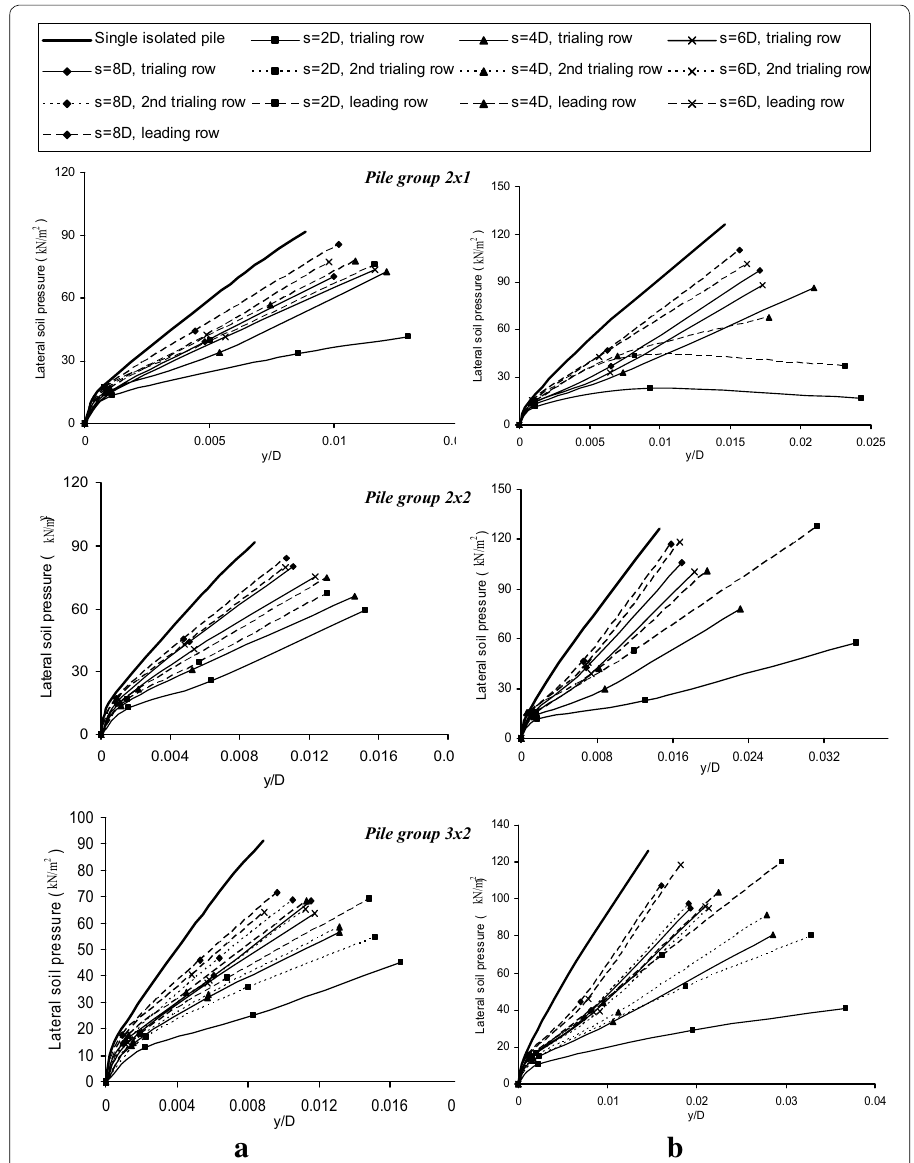
Fig. 8 Influence of pile spacing on the predicted of p–y curve of group piles (2 a cohesionless soil and b cohesive